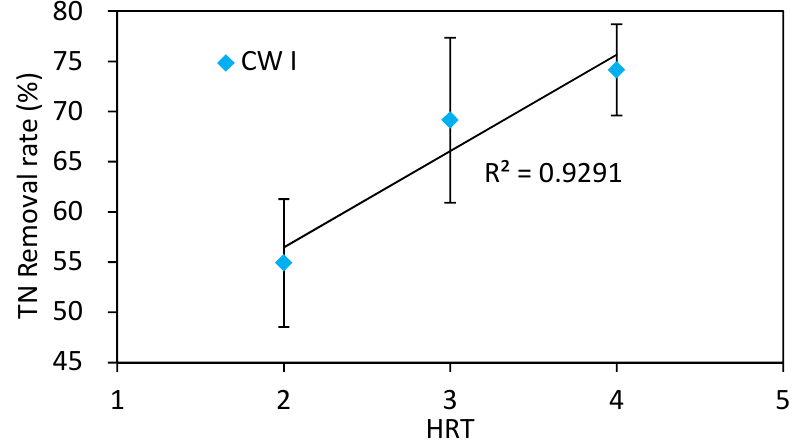
Figure 4. Correlation of the TN removal efficiency and the HRT.